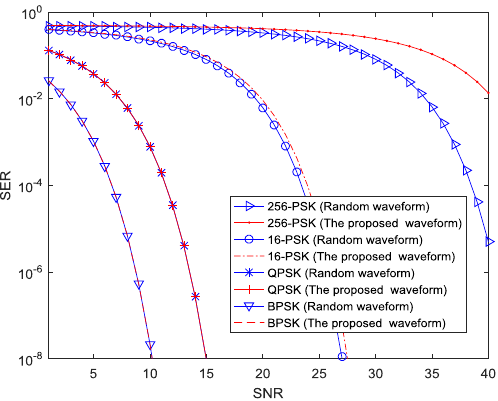
Figure 6. Comparative SER results of BPSK, QPSK, 16-PSK,